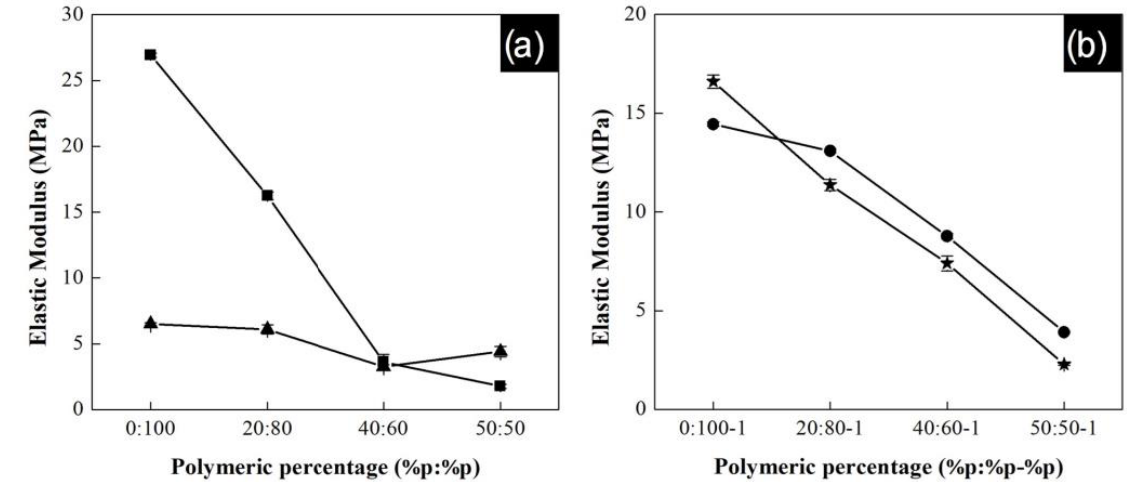
Figure 10. Curve elastic modulus as function of polymeric percentage with different CNTs contents: ( a ) P(S:AN); 0.5 wt.% CNTs ( ∎ ) ; 1.0 wt.% CNTs ( ▲ ) and ( b ) P(S:AN-AA); 0.5 wt.% CNTs ( ● ) and 1.0 wt.% CNTs ( ★ ) . Error bars indicate standard deviation.